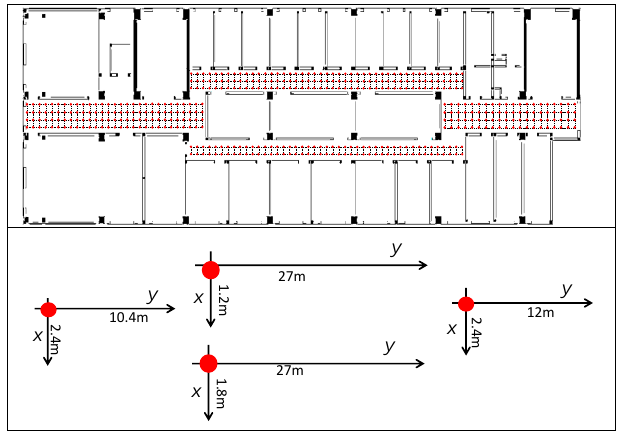
Figure 3. Experimental route area plan and coordinate system setting